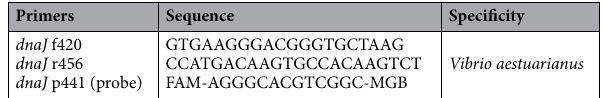
Table 6. Description of qPCR primer pair and probe used in the